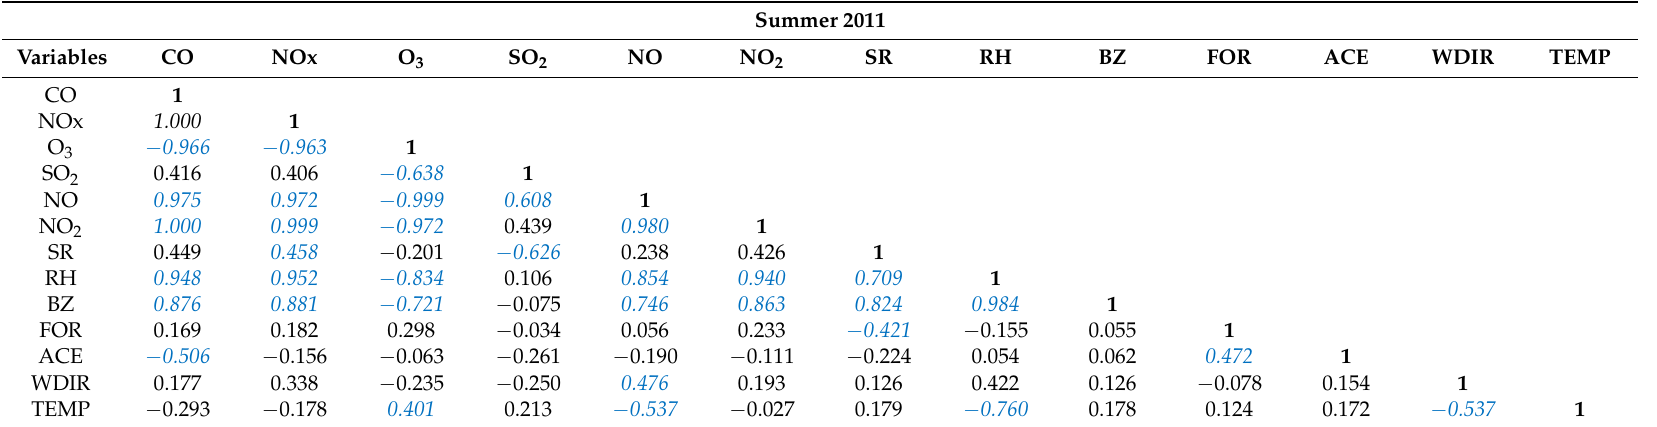
Table 5. Pearson correlation coefficients for benzene, formaldehyde, acetaldehyde, meteorological parameters, and criteria air pollutants during summer. Summer 2011